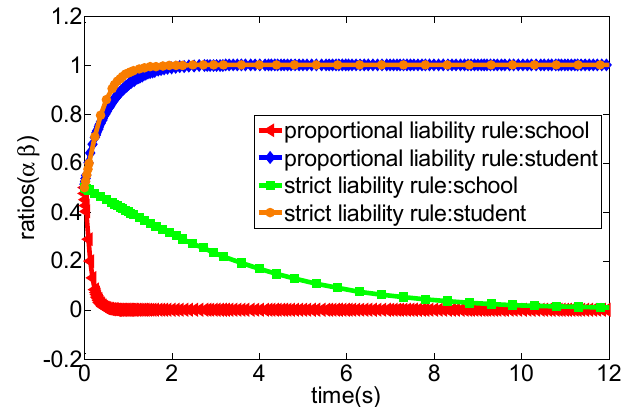
Figure 5. The evolution process of the system game strategy under the condition of low prevention cost from the student and high accident loss (case 4).